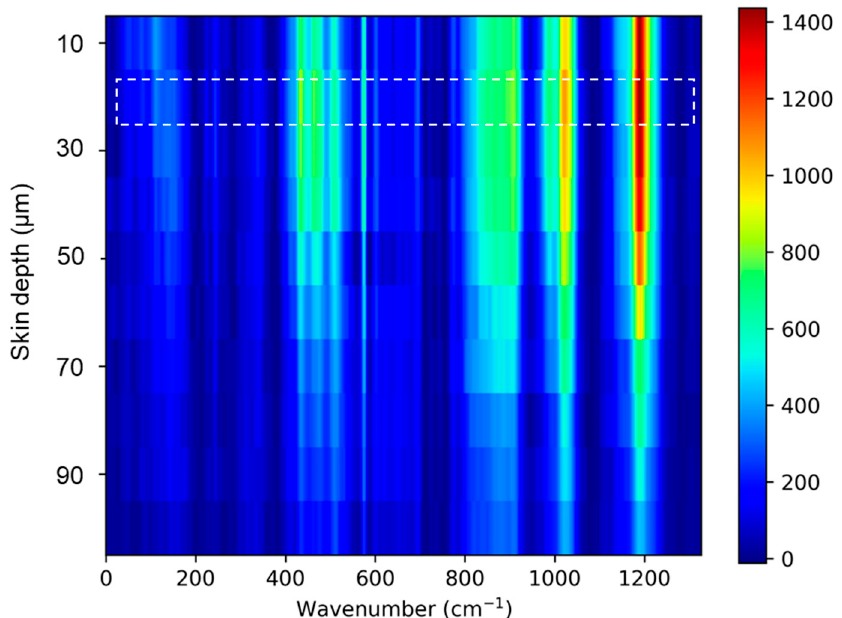
Figure A1. Raman spectral acquired from one of the healthy subject’s volar arm locations using handheld CRM system in the fingerprint region at 10 different depths (10 to 100 μ m).